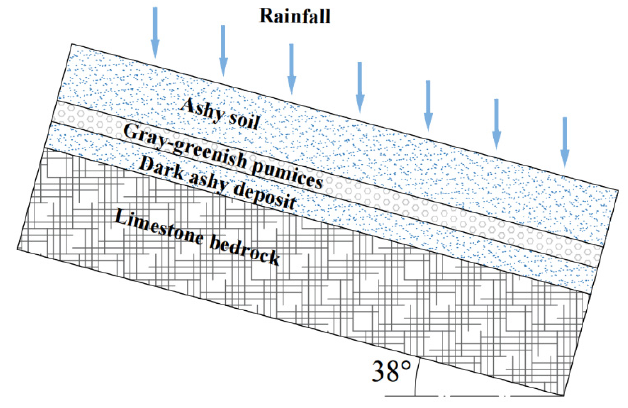
Figure 12. The scheme of the slope at Pizzo d’Alvano massif. Table 4. Main physical and mechanical properties of the materials in Pizzo d’Alvano